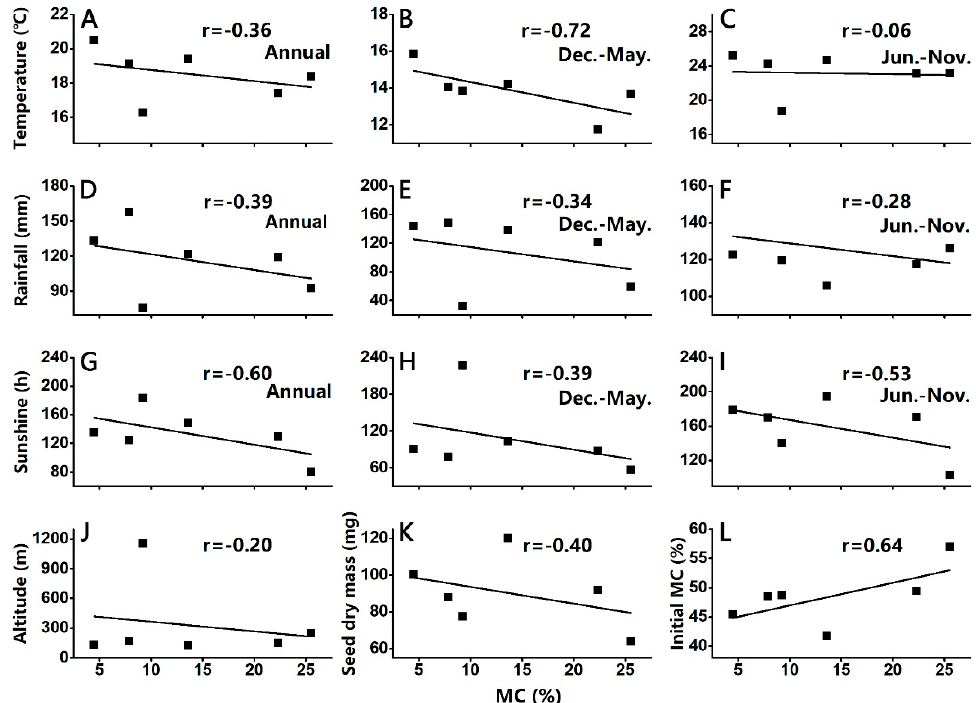
Figure 2. Correlation between the seed MC at which germination was interpolated to be probit 5.5 and Citrus sinensis ‘bingtangcheng’ seed lot characteristics as well as environmental conditions of the collecting sites. ( A – C ) Average temperature (°C), ( D – F ) average rainfall (mm), ( G – I ) sunshine hours ( H ), ( J ) altitude, ( K ) seed dry mass and ( L ) initial moisture content. Climate conditions were averaged for Dec.–May (after fruit dispersal and before fl owering) and Jun.–Nov. (after fl owering).